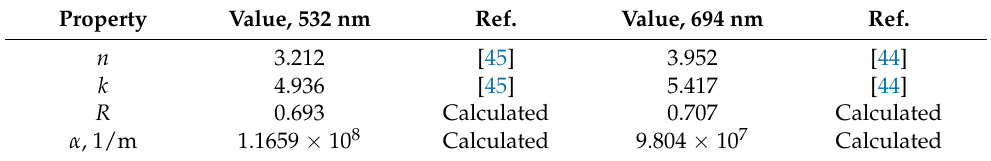
Table A4. Liquid -Si—optical properties.